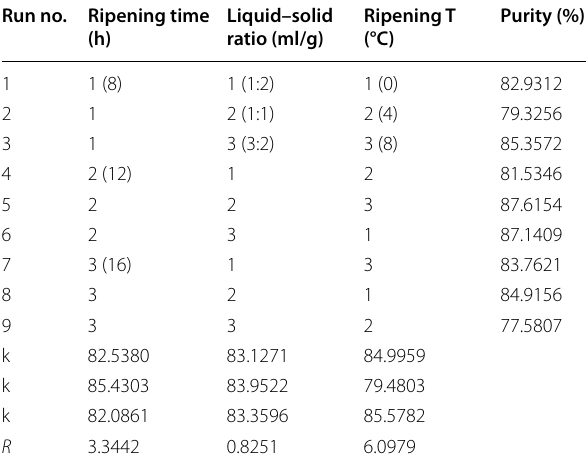
Table 5 Results of orthogonal test and range